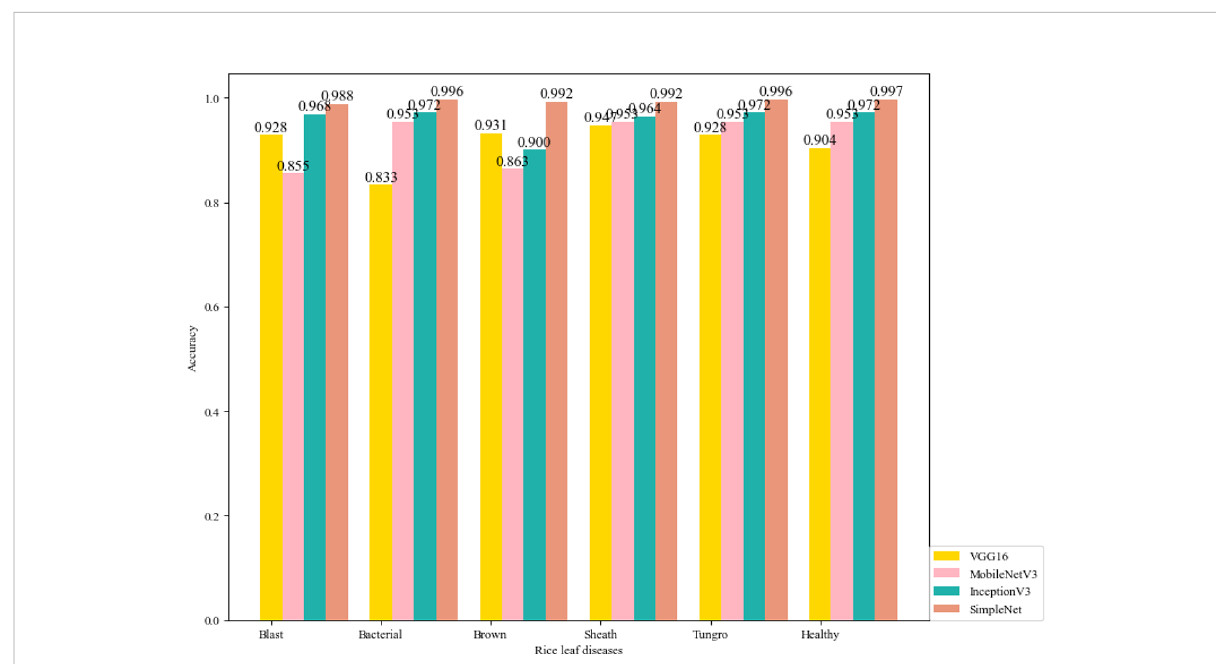
FIGURE 7 Recognition accuracy of four CNNs for the six kinds of rice leaf disease